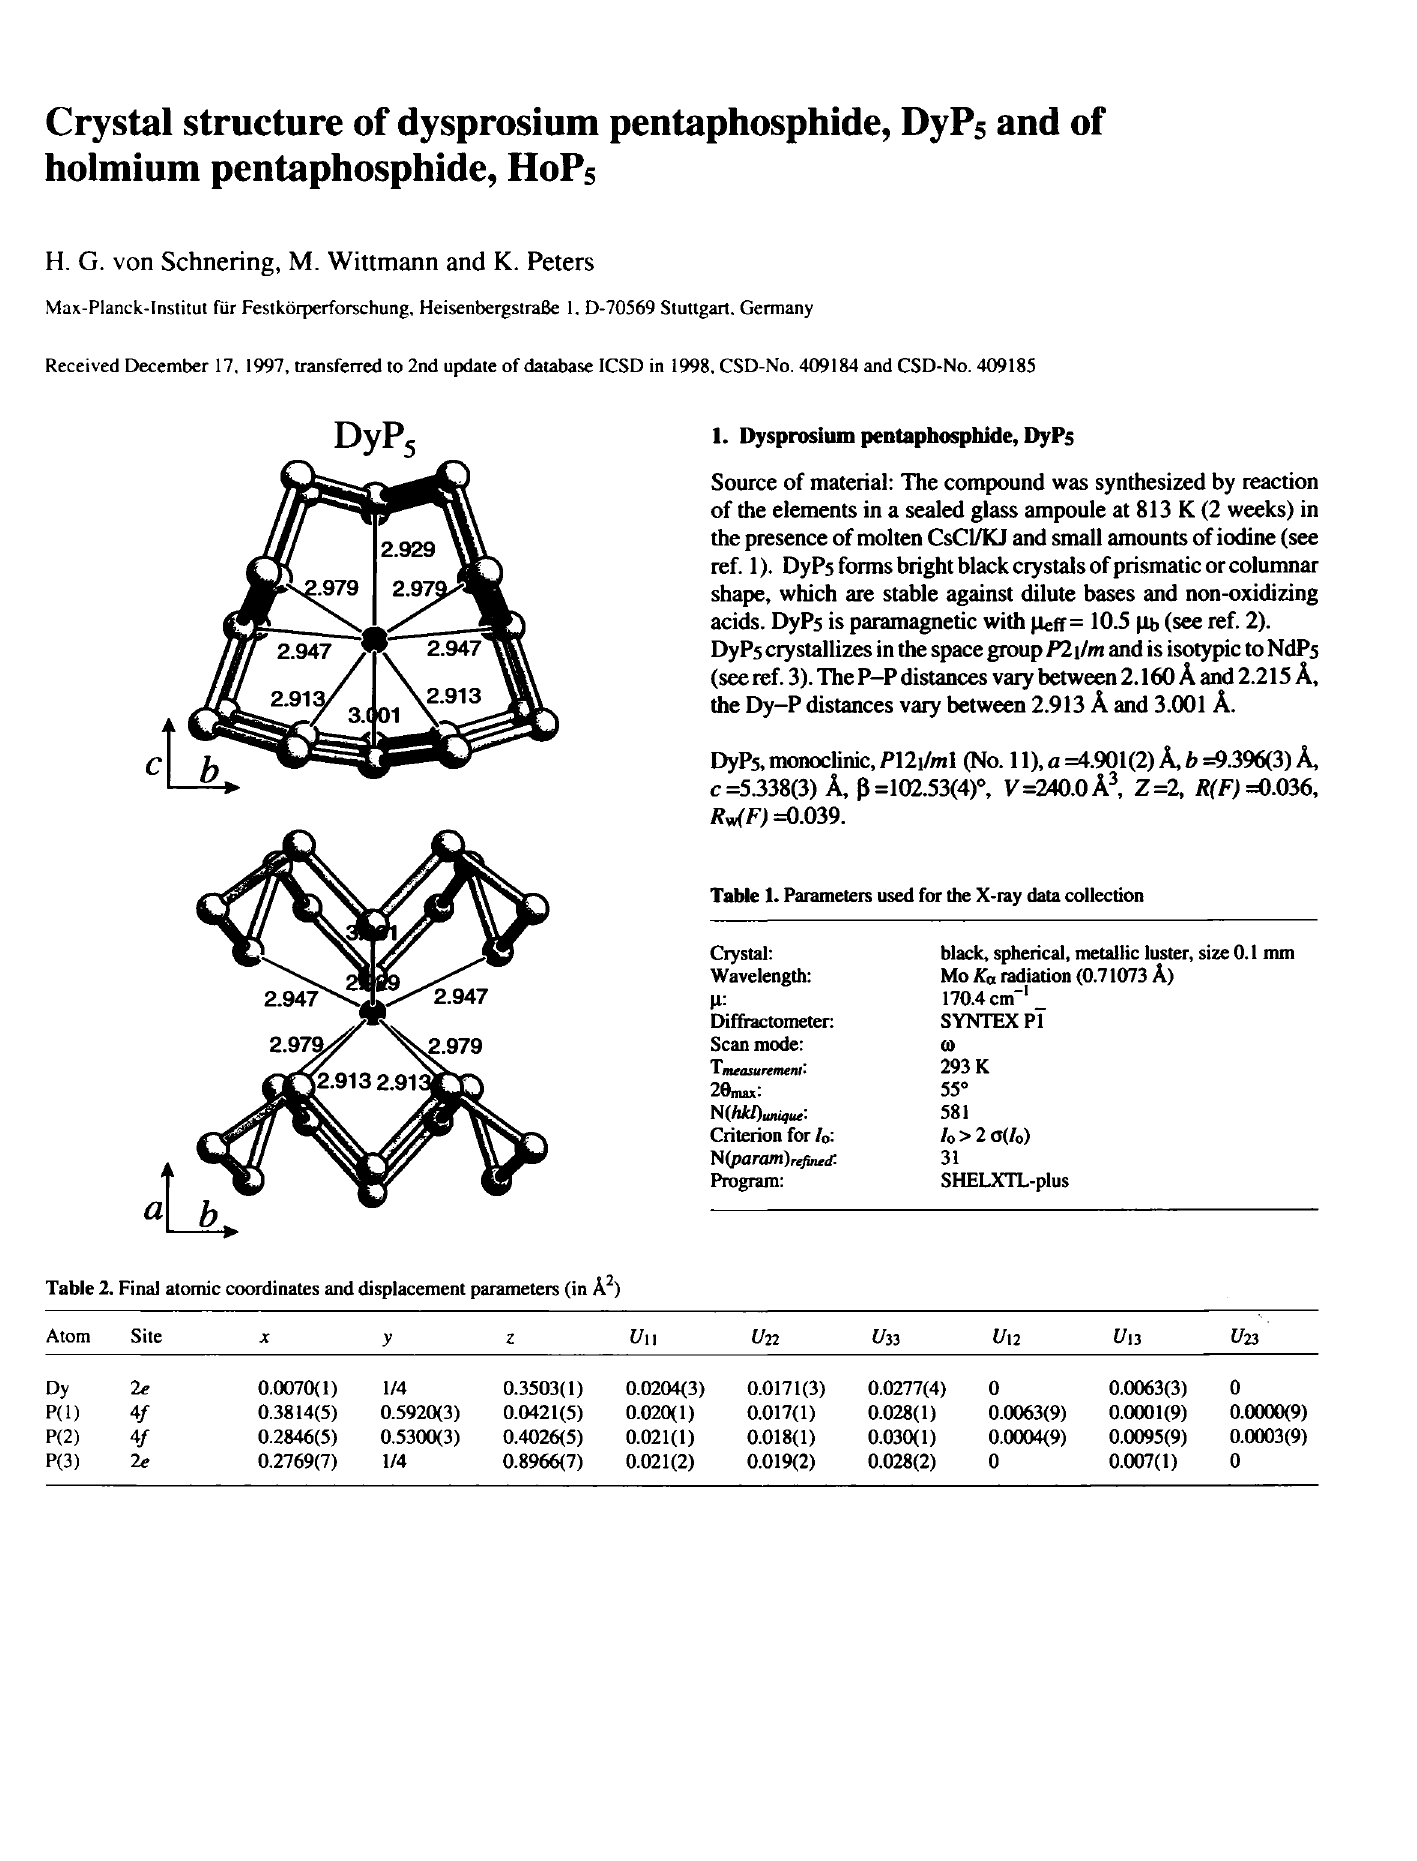
Table 2. Final atomic coordinates and displacement parameters (in Â^) Atom